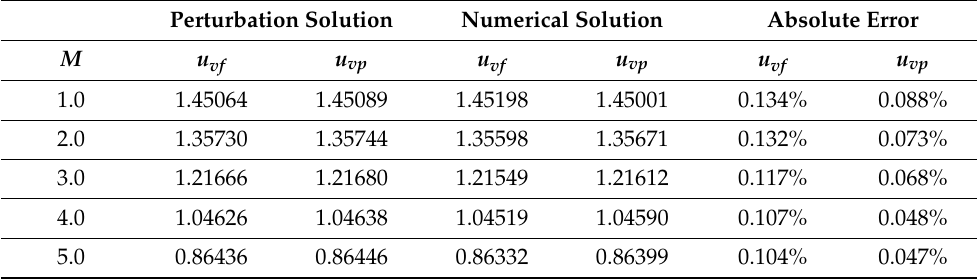
Table 1. Absolute error between perturbation and numerical solutions.